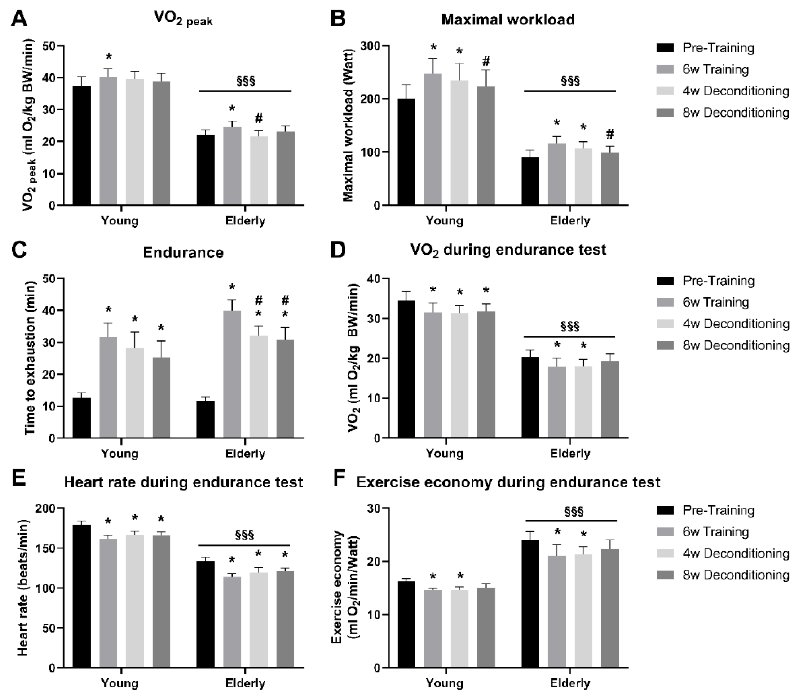
Figure 2. Functional parameters of aerobic capacity. ( A ) Maximal oxygen consumption rate (VO 2peak ) and maximal workload ( B ) measured in an incremental bicycle test before and after 6 weeks of aerobic exercise training and after 4 and 8 weeks of subsequent deconditioning in elderly and young men and women. Time to exhaustion ( C ), average VO 2 ( D ), average heart rate ( E ), and exercise economy ( F ) during an endurance test on bicycle at 80% of maximal workload in elderly and young men and women. n = 10 in young and n = 11 elderly. * Significantly di ff erent ( p < 0.05) from pretraining within age group. # Significantly di ff erent ( p < 0.05) from 6 weeks of training within age group. §§§ Significantly di ff erent ( p < 0.001) from young participants. All data are presented as means ± standard error